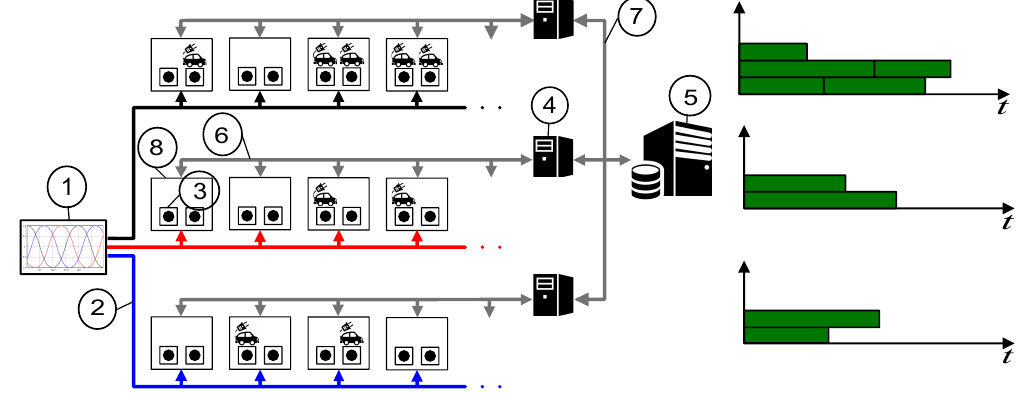
Figure 1. Components of the charging station: (1) power source; (2) three-phase electric power; (3) charging points; (4) masters; (5) server with database; (6) asynchronous serial connections; (7) communication TCP/IP (Transmission Control Protocol/Internet Protocol); (8) slaves. The Gantt Chart on the right shows the charging intervals of the vehicles in each line in a feasible schedule for n = 3 and ∆ =